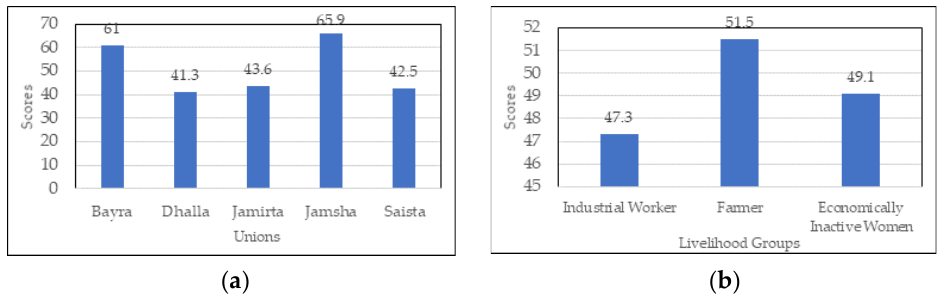
Figure 11. Score for environment component for: ( a ) 5 unions; and ( b ) livelihood groups.